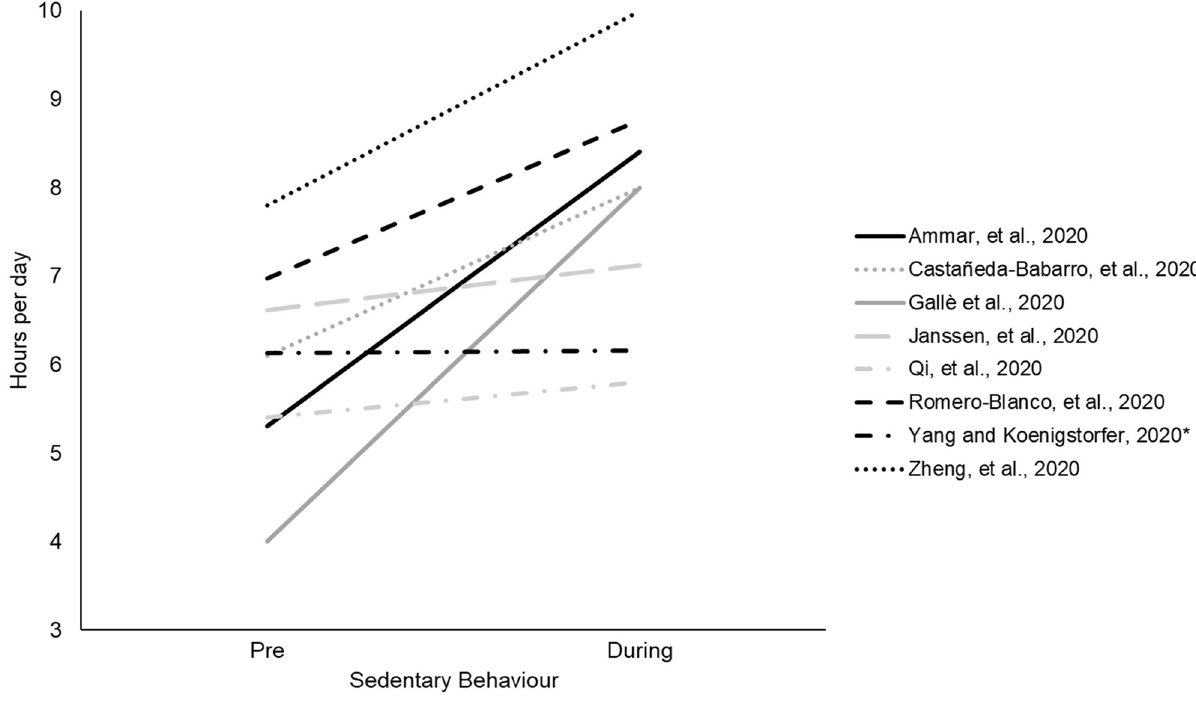
Fig 4. Change in time spent in sedentary behaviour from pre- to during COVID-19. Asterisk indicates non-significant difference.